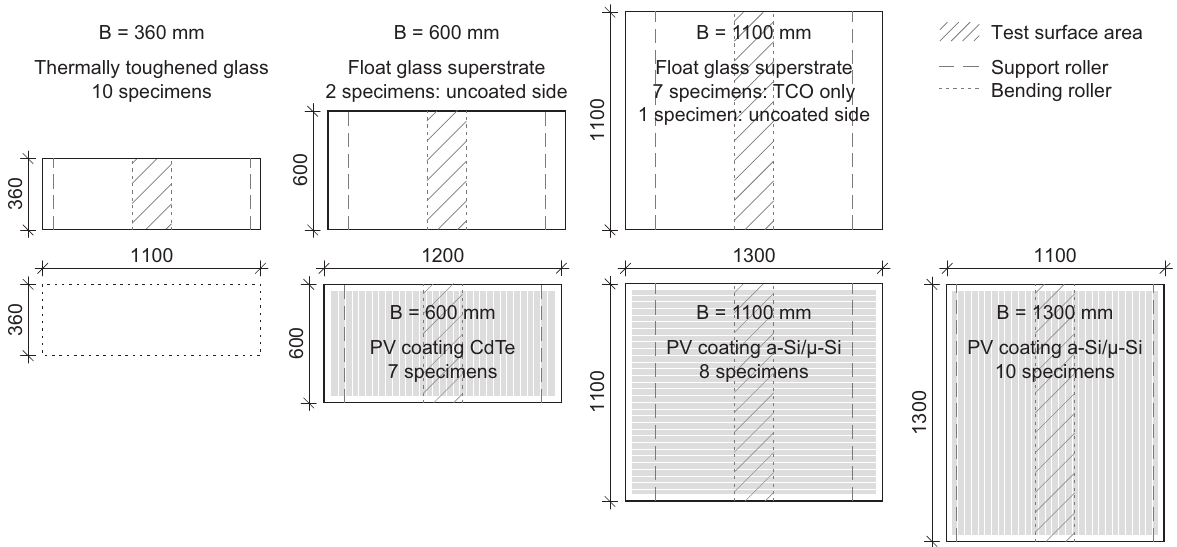
Fig. 2 Standard-size thermally toughened glass specimens and modified specimen